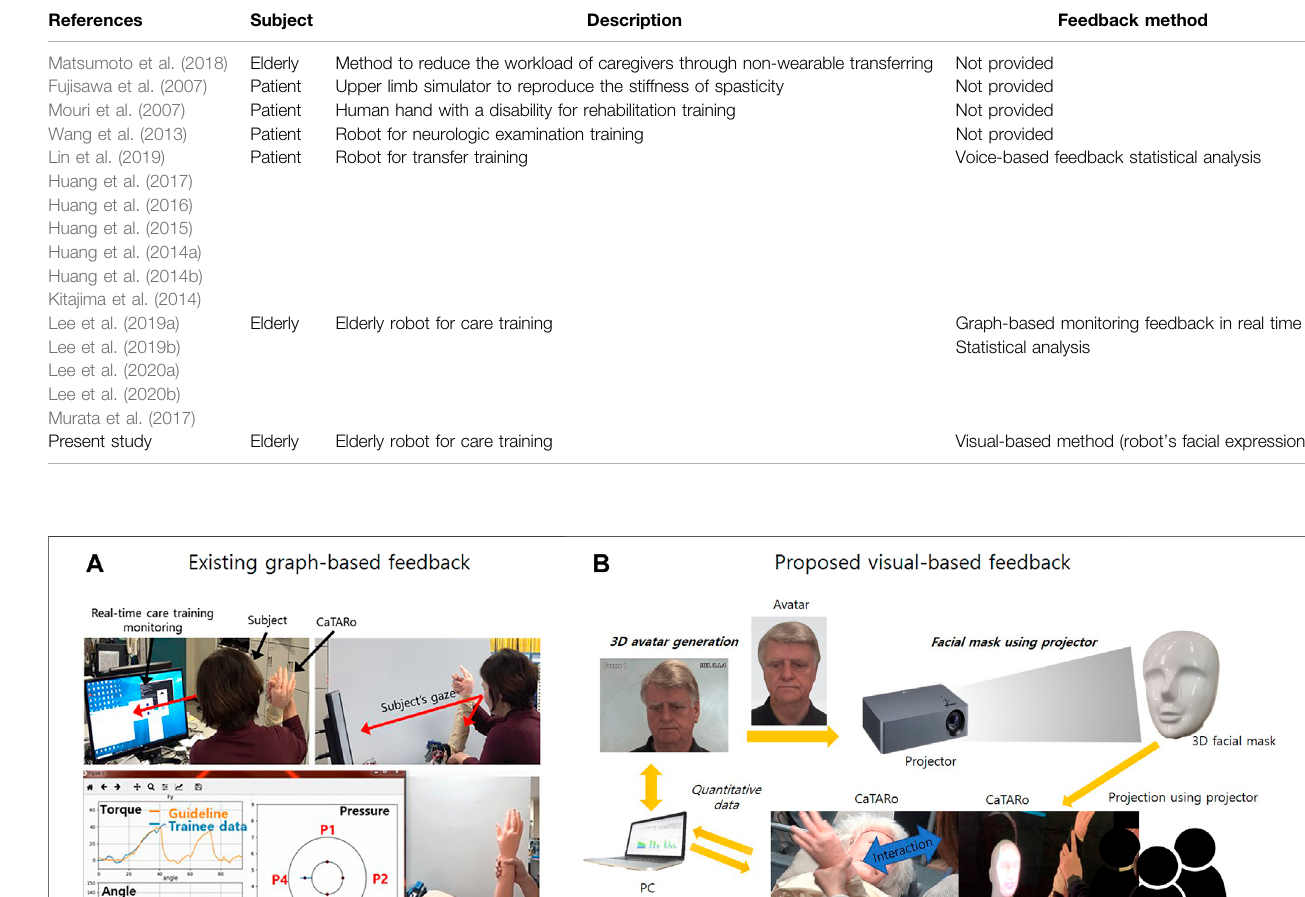
TABLE 1 | Comparison between the related work and the method proposed in this work.